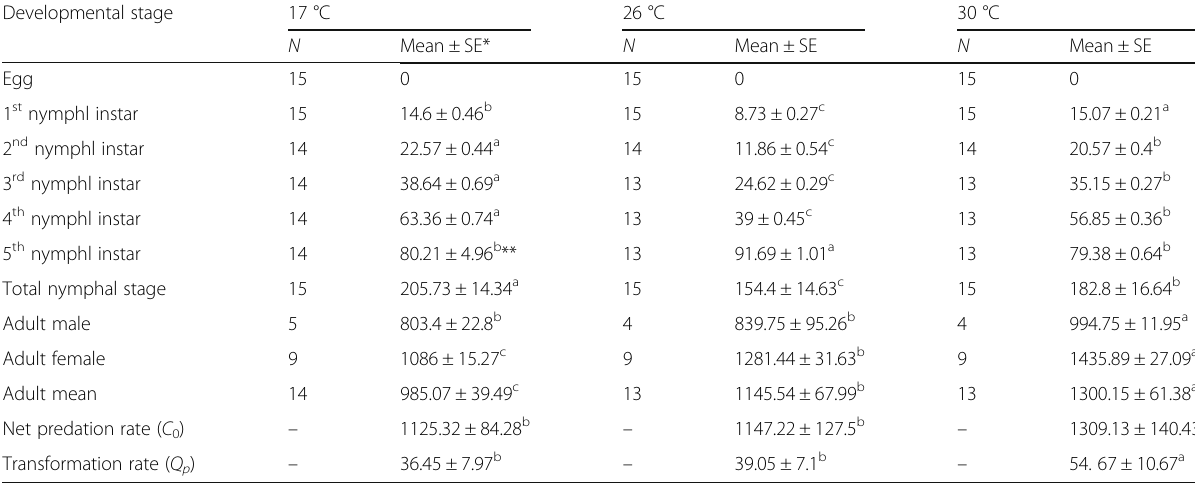
Table 1 Mean consumption capacity, C 0 , and Q p of Anthocoris minki pistaciae fed on Agonoscena pistaciae at three different temperatures under laboratory conditions Developmental